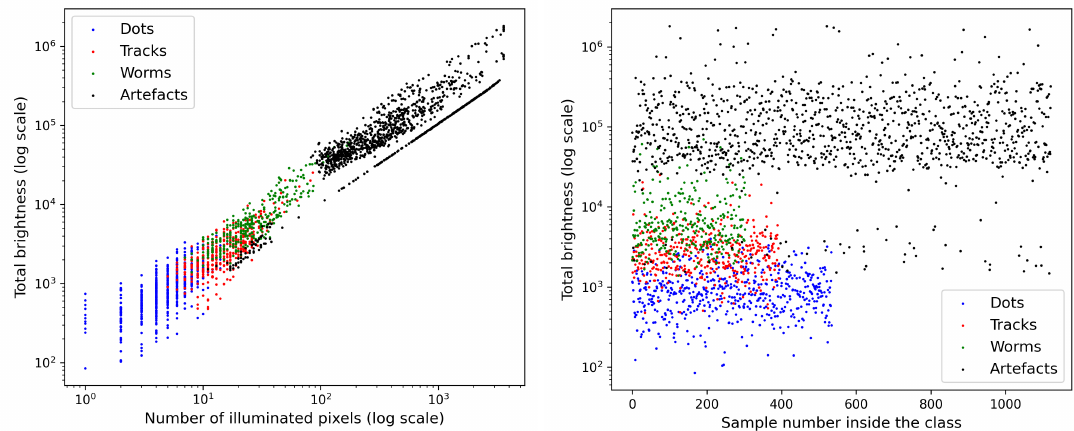
Figure 5. Illustration of the separation of different signal categories with respect to the cumulative brightness and number of illuminated points: ( left ) brightness and number of pixels plot, ( right ) brightness plot.